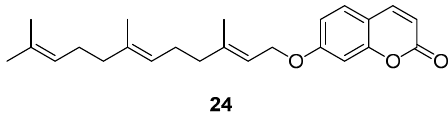
Figure 13. Chemical structure of umbelliprenin ( 24 ).